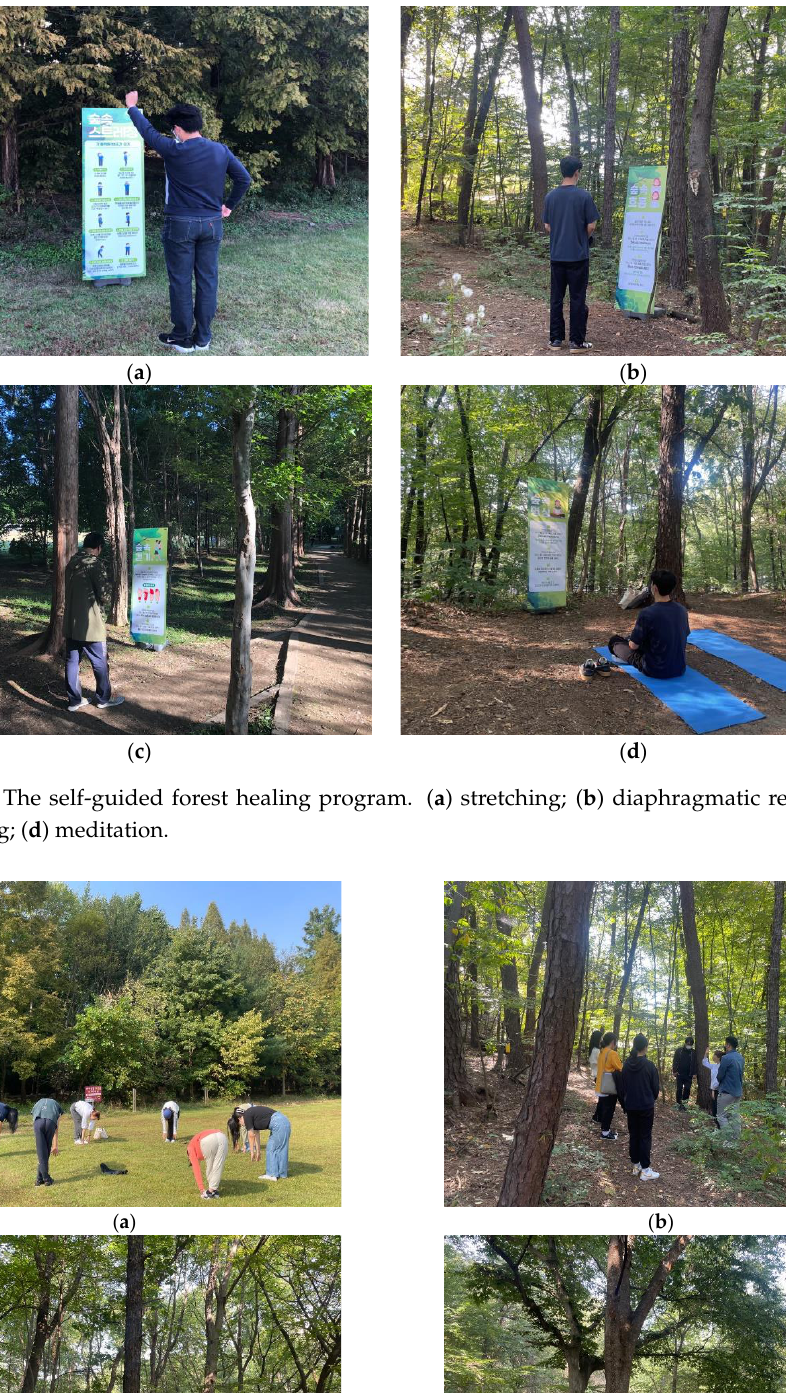
Figure 2. Example of a self-guided forest healing program guideboard. ( a ) stretching; ( b ) walking.